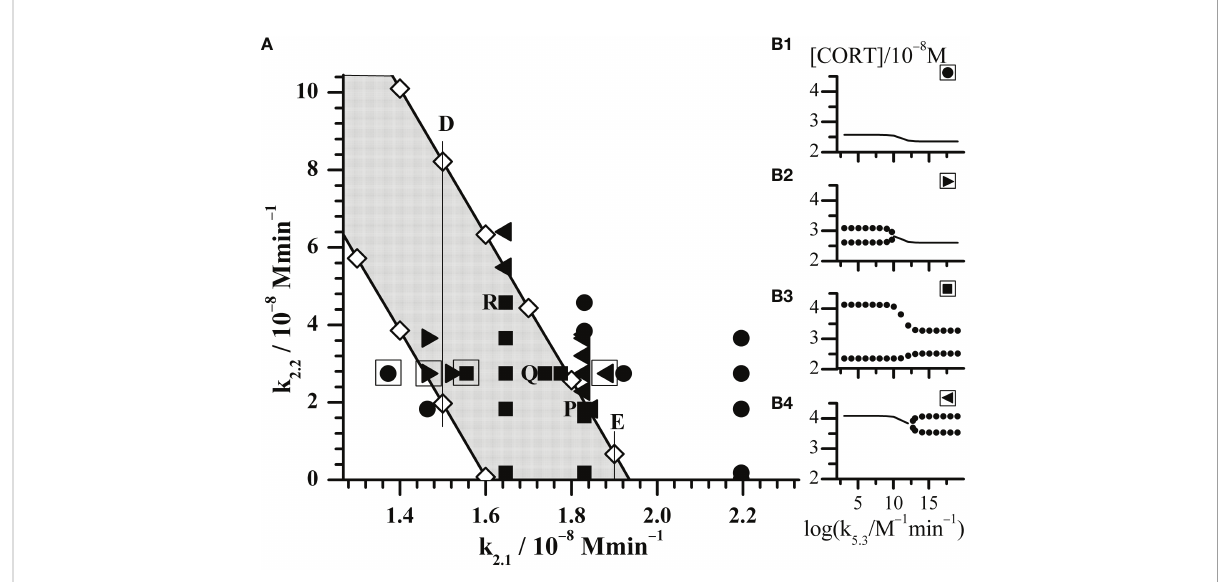
FIGURE 2 Enlarged part of the bifurcation diagram framed by rectangle in Figure 1. (A) Black symbols represent dynamic states identi fi ed by Method 2 with increasing k 5.3 as control parameter. Circles ( ● ) depict points where only stable steady states were found; right triangles ( ► ) depict points where transition from oscillatory states into stable steady states was observed; squares ( ◼ ) depict points where only oscillatory states were observed; left triangles ( ◄ ) depict points where transition from stable steady states into oscillatory states was observed. (B1 – B4) the outlooks of bifurcation diagrams depicted by corresponding black symbols in the square-bordered examples. The selected points P, Q and R will be discussed in Figure